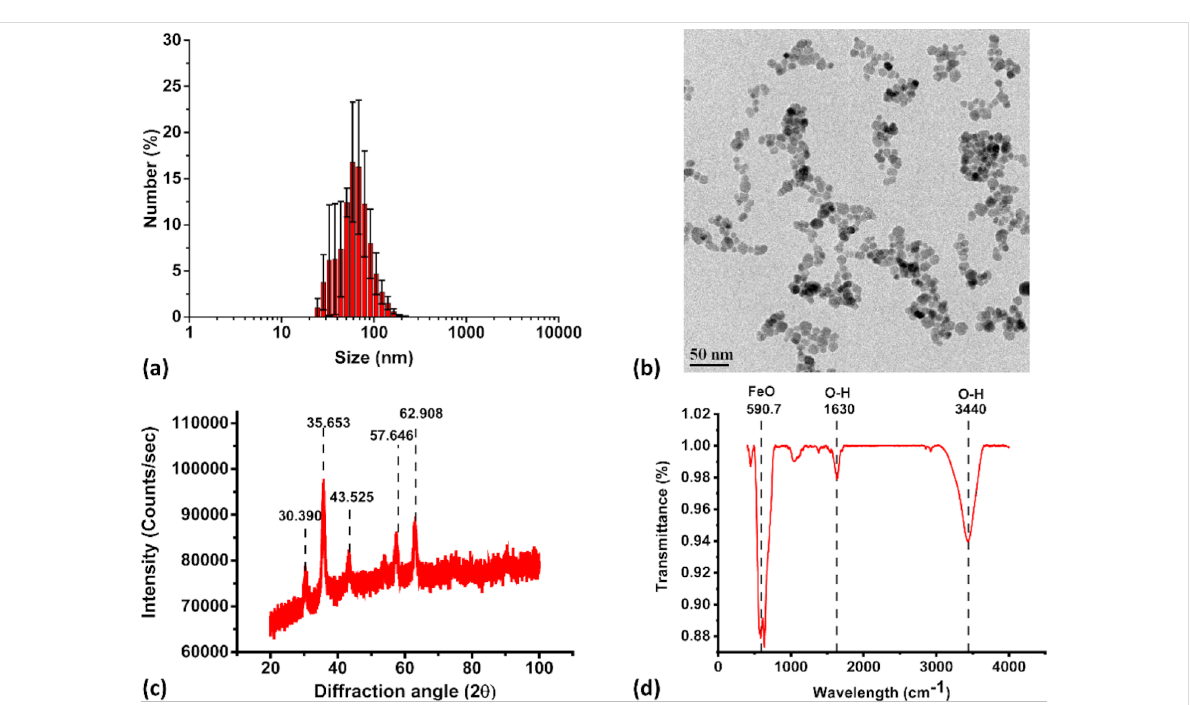
Figure 4: Characterization of NOR@IONP pH10 nanoparticles. (a) Dynamic light scattering plot of number (%) v/s size (nm) of the nanoparticles in solution at the completion of synthesis ( n = 3). (b) Transmission electron microscopy image with a 50 nm scale bar. (c) X-ray diffraction pattern indi- cating the Bragg’s angle corresponding to those observed in iron oxide. (d) FTIR plot of transmittance v/s wavenumber depicting functional groups of iron